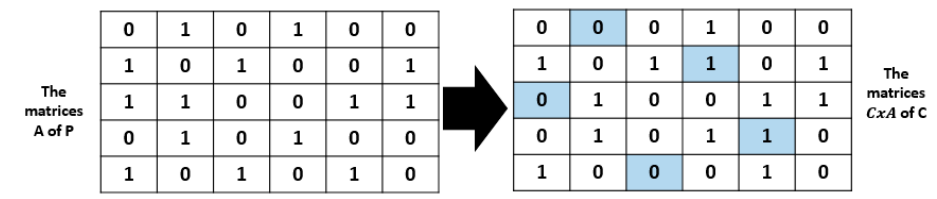
Figure 12. The Morocco highway (Meknes “A”–Fez “B”). 4.3.6. Transport Network Data The objective in this paragraph is to install a set of gates on the DWCS road to organ- ize the use and the payment of the use of charging lanes by the vehicles. The first step to achieving the goal is to build the DWCS infrastructure for the electric vehicles with the minimum cost using the model of Bourzik and EL Hilali Aaloui [3]. As mentioned previ- ously, their method consists of discretizing the road into segments with the same length, then determining, according to the battery state of each vehicle, the active and the inactive segments. The length of the Morocco highway A-B is 60 km. The road was discretized into segments of 250 m, the first segment noted by 1 and the last noted by 240. As mentioned, successive active (inactive) segments form an active (inactive) charging lane. Table 4